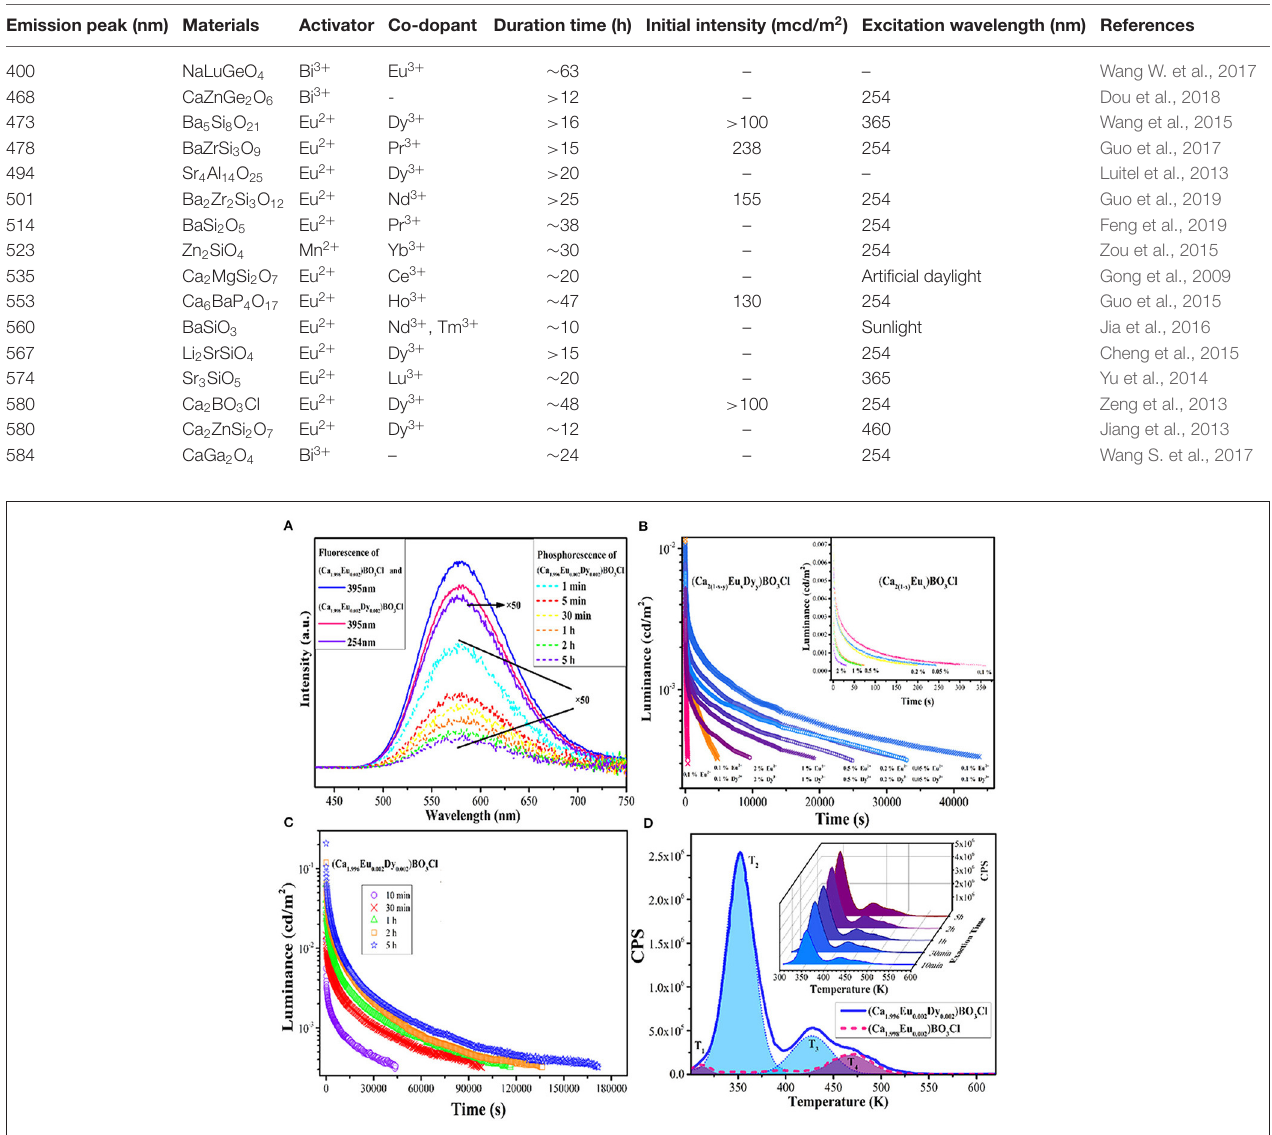
FIGURE 1 | (A) PL spectra of Ca 2 BO 3 Cl: 0.002Eu 2 + and Ca 2 BO 3 Cl: 0.002Eu 2 + , 0.002Dy 3 + and LPL spectra of Ca 2 BO 3 Cl: 0.002Eu 2 + , 0.002Dy 3 + . (B) LPL decay curves of Ca 2 BO 3 Cl: xEu 2 + , yDy 3 + and Ca 2 BO 3 Cl: xEu 2 + samples (inset). (C) LPL decay curves of Ca 2 BO 3 Cl: 0.002Eu 2 + , 0.002Dy 3 + excited at different times. (D) TL curves of Ca 2 BO 3 Cl: 0.002Eu 2 + , 0.002Dy 3 + and Ca 2 BO 3 Cl: 0.002Eu 2 + excited for 10min and TL curves of Ca 2 BO 3 Cl: 0.002Eu 2 + , 0.002Dy 3 + excited for different times (inset). Reproduced by permission of The Royal Society of